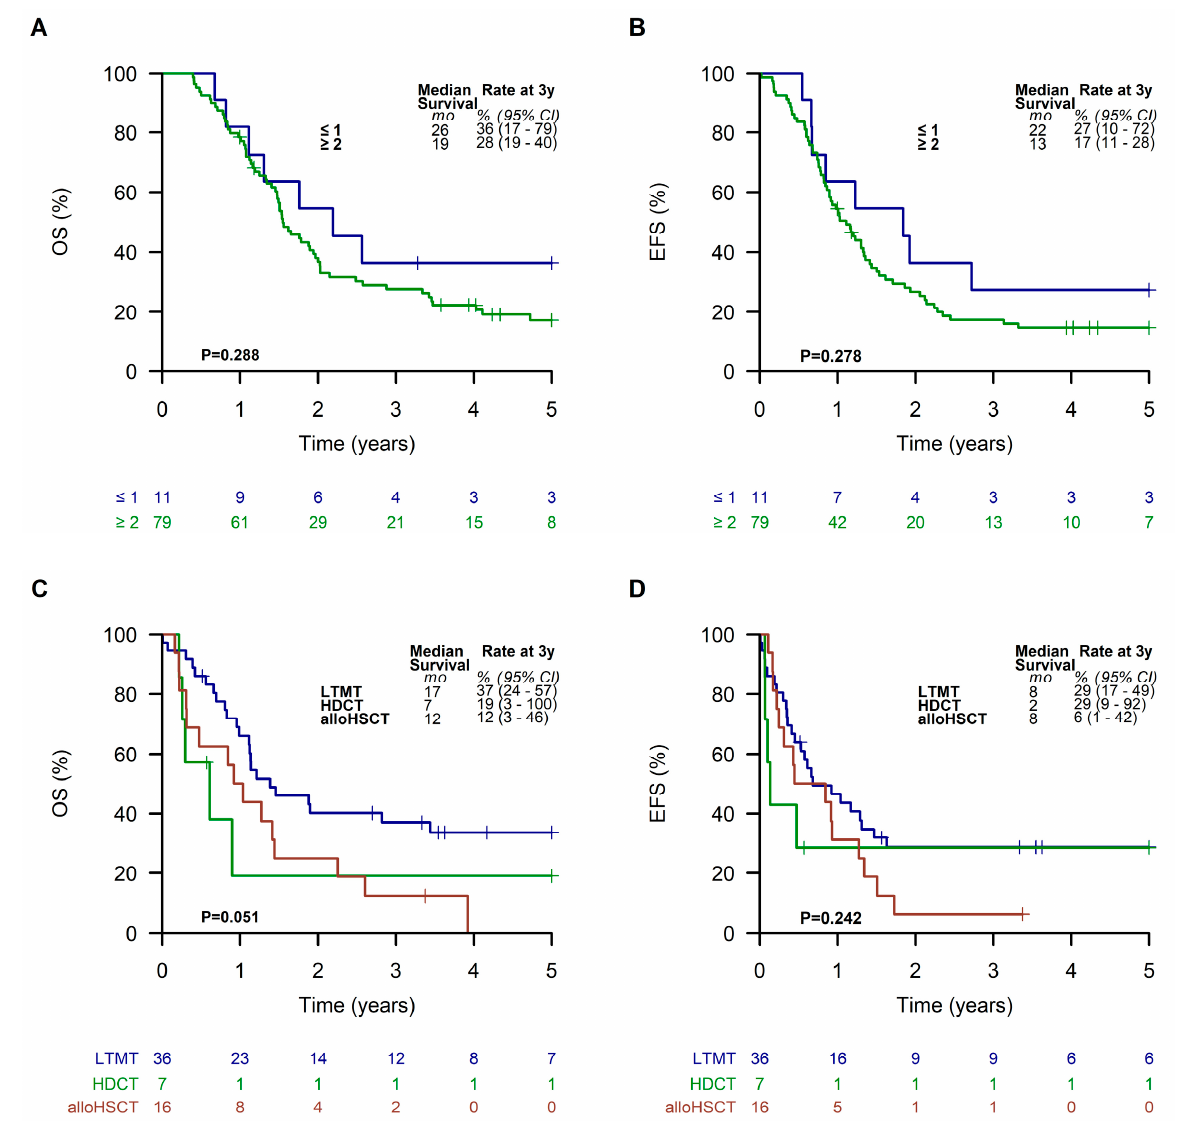
Figure 6. Overall survival ( A ) and event-free survival ( B ) of all patients with an alveolar RMS and an Oberlin risk score of ≥ 2. Overall survival ( C ) and event-free survival ( D ) of patients with an alveolar RMS and an Oberlin risk score of ≥ 2 receiving a metronomic long-term maintenance therapy (LTMT), high-dose chemotherapy (HDCT), or allogeneic hematopoietic stem cell transplantation (alloHSCT).